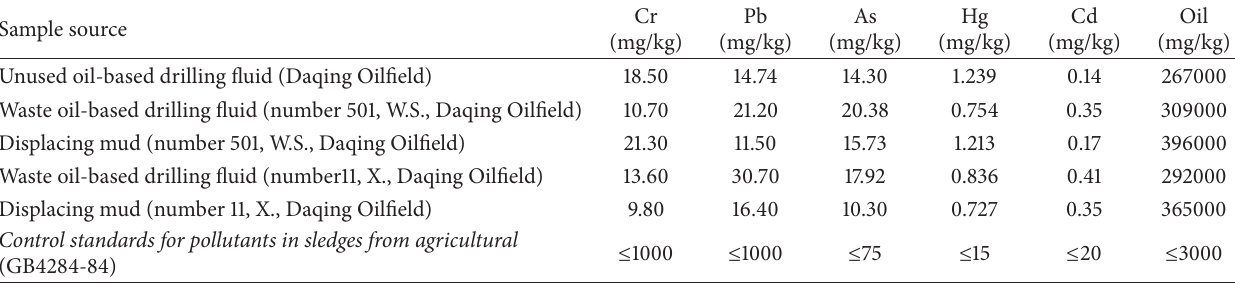
Table 2: Main pollutants in waste oil-based drilling fluid.